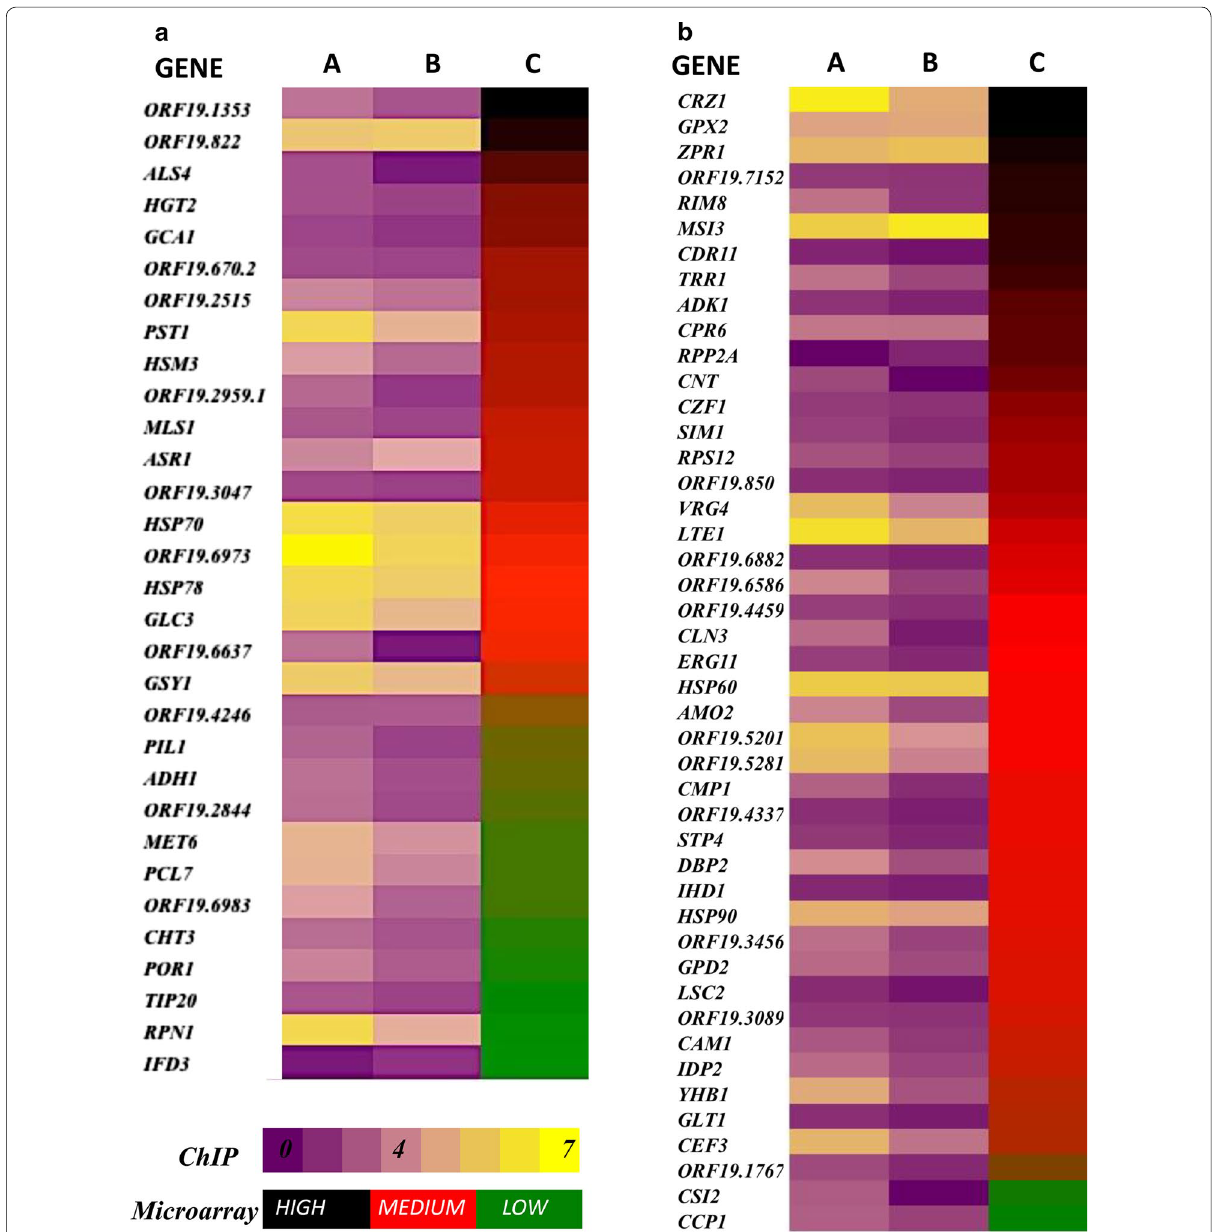
Fig. 5 Comparative analysis of microarray and ChIP data under iron deprivation conditions—genes which showed binding of Hsf1 (ChIP data) and also were iron responsive (microarray data) were grouped into two categories. a Upregulated upon iron deprivation. b Down regulated upon iron deprivation. Column A-binding intensity in wildtype (ChIP) Column B-binding intensity in iron deprivation (ChIP) Column C-mean log fold expression change upon iron deprivation (Microarray). The binding intensities in normal and iron deprived conditions is depicted alongside the fold change in its expression upon iron deprivation according to